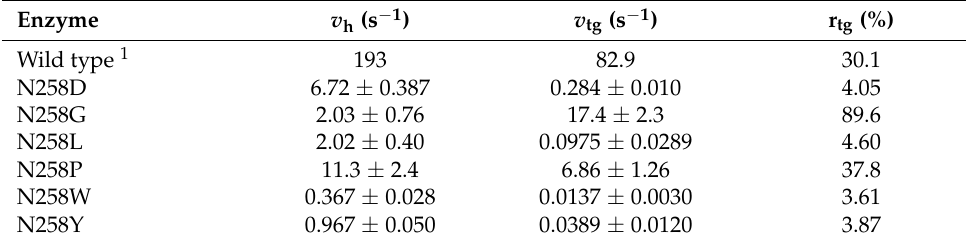
Table 2. Reaction rates of Asn258 variants of BspAG13_31A to 10 mM G2. Enzyme v h (s − 1